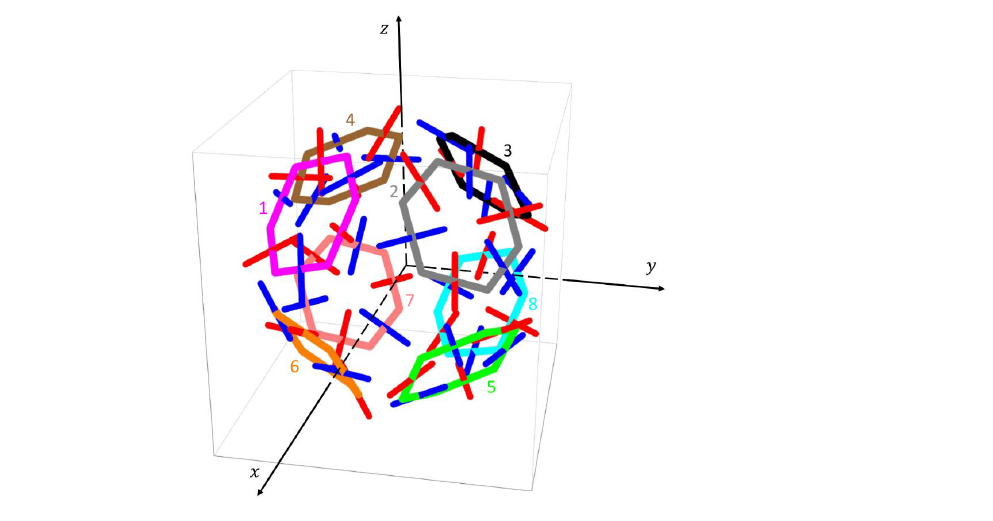
Figure 3. Hexagons in the unit cell of the chiral cubic phase in the laboratory system. Red and blue lines represent different inclinations of anisotropic scatterers with respect to the hexagon sides. All hexagons are identical (see Figure 2); they differ only by location and orientation inside the unit cell. The tensor form factor of the unit cell is a sum of the tensor form factors of all the hexagons in the unit cell. Once a single hexagon with the belonging scatterers is defined in the coordinate system centered on the hexagon, we can use translations and rotations to place it in the proper position; the center of each hexagon is in the center of each octant of the unit cell. Orientation of each individual hexagon in the laboratory coordinate sys- tem, the origin of which is in the center of the unit cell and the axes (𝑥,𝑦,𝑧) run along the unit cell sides, is determined by the directions of axes 𝑥 ℎ and 𝑦 ℎ , which are given by the unit vectors 𝑑̂ 1𝑙𝑎𝑏 and 𝑑̂ 2𝑙𝑎𝑏 . These parameters for our model are presented in Table 2. Table 2. Coordinates of the centers 𝑟 𝑠(𝑖) of hexagons within the unit cell with a side length 𝑎 , unit vectors 𝑑̂ 1𝑙𝑎𝑏 and 𝑑̂ 2𝑙𝑎𝑏 along the direction of vectors 𝑑⃑ 1 and 𝑑⃑ 2 (see Figure 2) given in the labora- tory coordinate system ( 𝑥 , 𝑦 , 𝑧 ) (Figure 3).